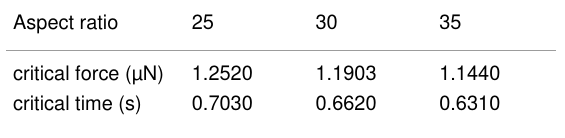
Table 7: Critical forces and times of a cylindrical gold nanoparticle in sliding mode with respect to change in aspect ratio. Aspect